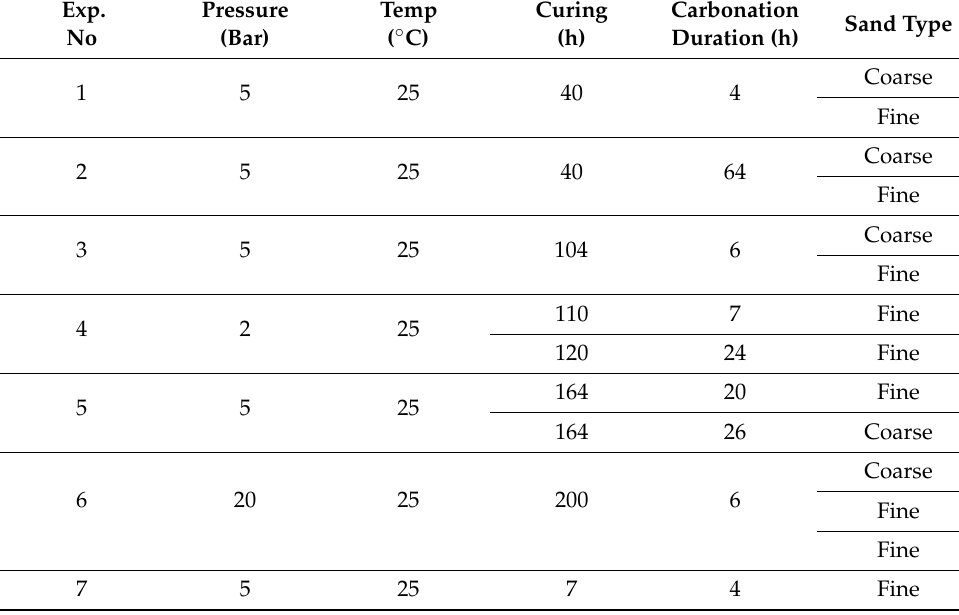
Table 1. Summary of the experimental conditions of the different tests.